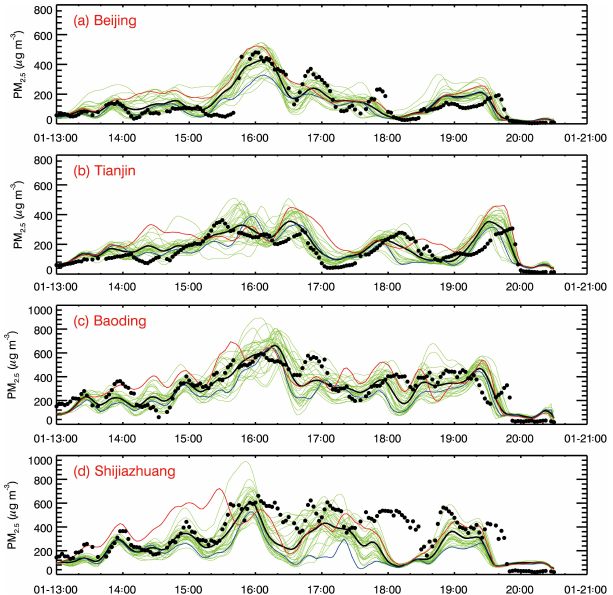
Figure 10. Temporal evolution of the PM 2 . 5 mass concentrations averaged in (a) Beijing, (b) Tianjin, (c) Baoding, and (d) Shiji- azhuang from each ensemble member (thin green lines), the ensem- ble mean (bold black line), and observations (black dots) during the period from 13 to 20 January 2014. The red and blue lines represent the simulations in the members with the highest and lowest PM 2 . 5 concentrations,